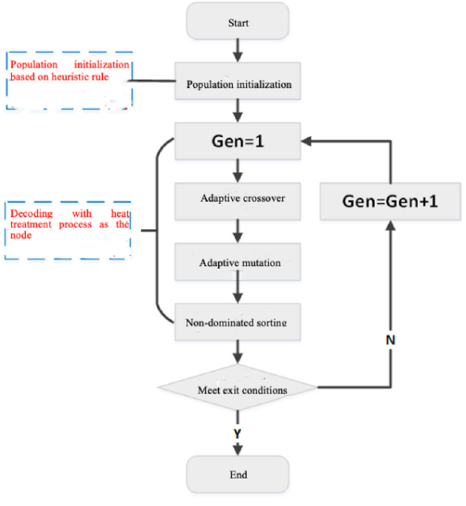
Figure 2. Improved NSGA.